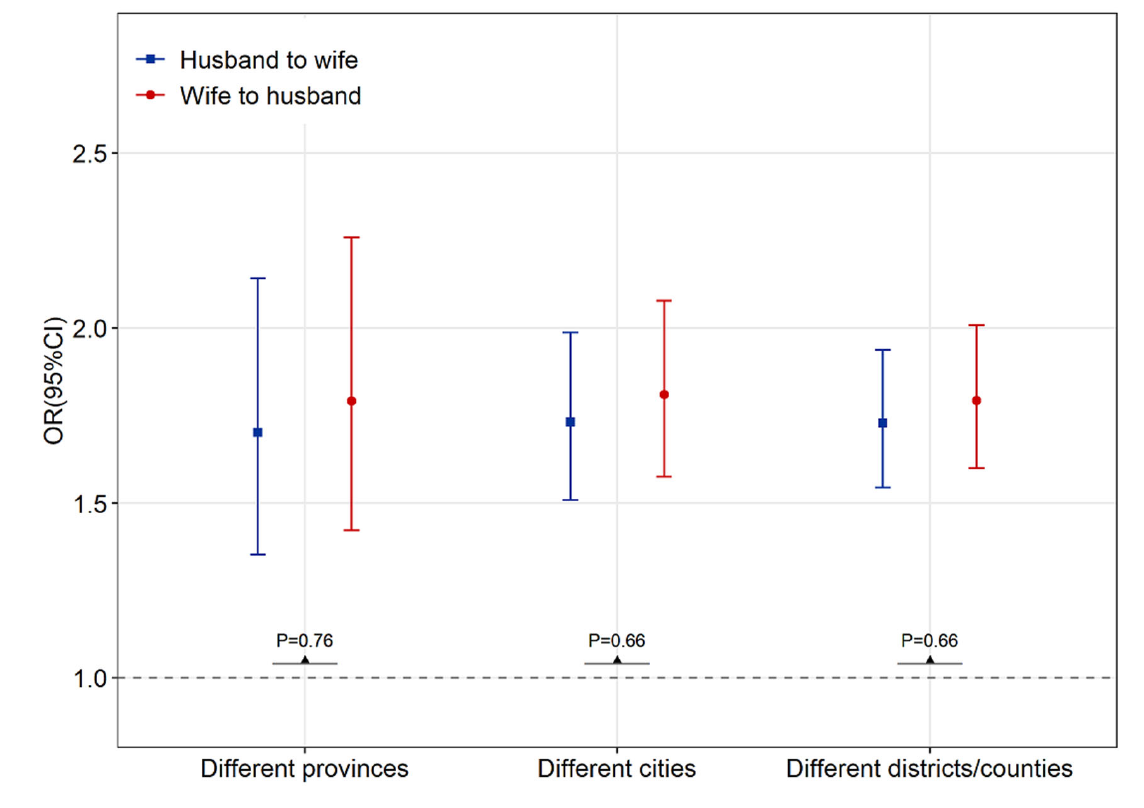
Figure 2. Reciprocal NAFLD association among older couples with different places of origin, stratified by those born in different provinces, cities, or districts/counties, for the period 2018–2020. Note: p -value for gender interaction. Abbreviations: OR: odds ratio; CI: confidence intervals.